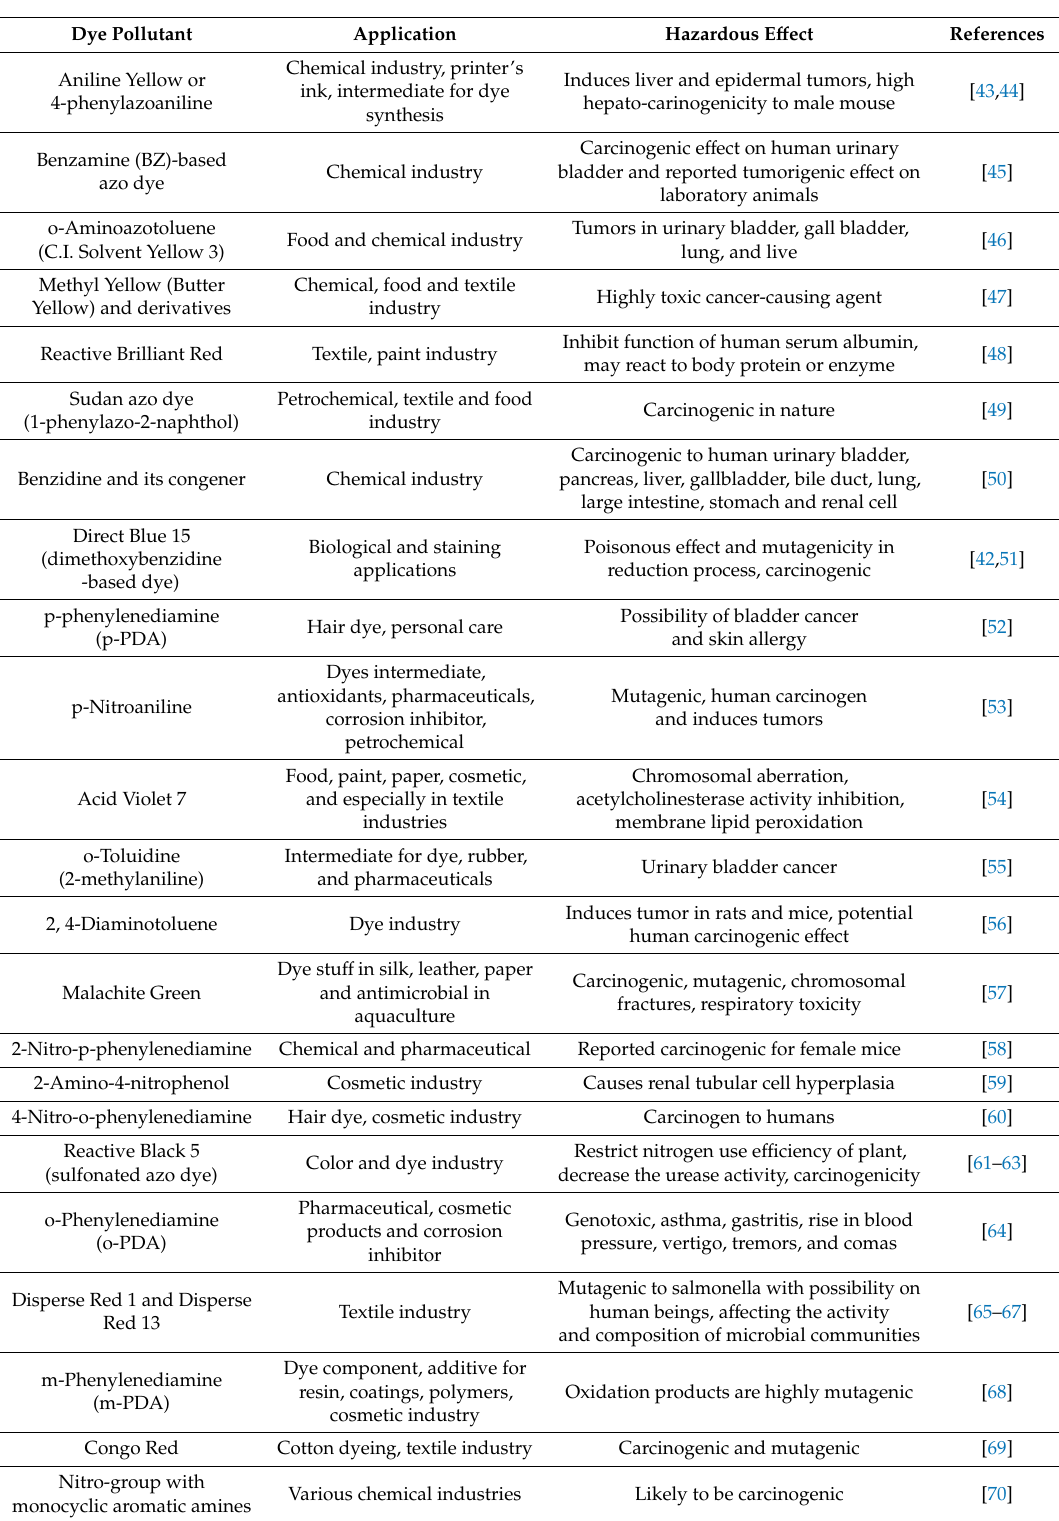
Table 1. Selected synthetic dyes commonly used in the textile industry: their types, applications, and hazardous e ff